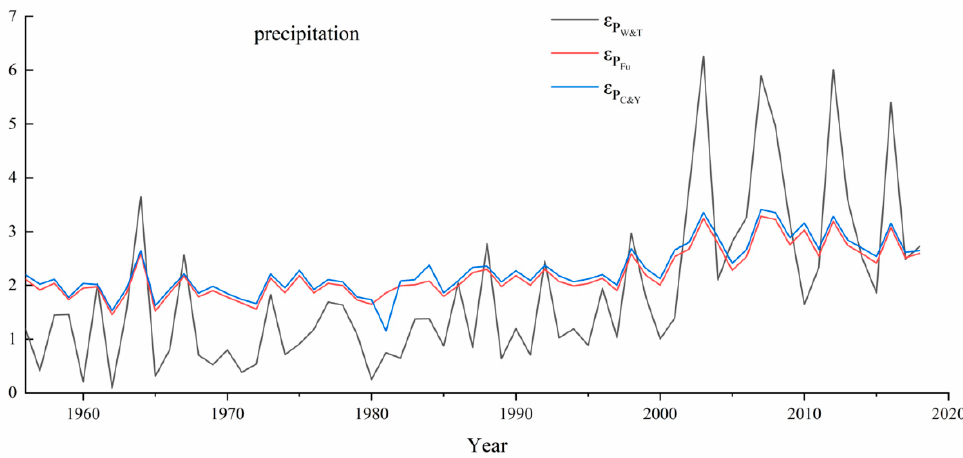
Figure 5. Elasticity coefficients of precipitation for three Budyko methods from 1956 to2018.